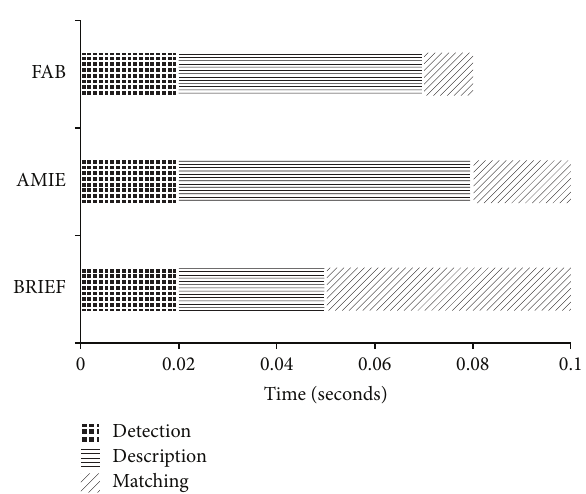
Figure 4: Comparison of computation and matching time of FAB with BRIEF and AMIE averaged over 100